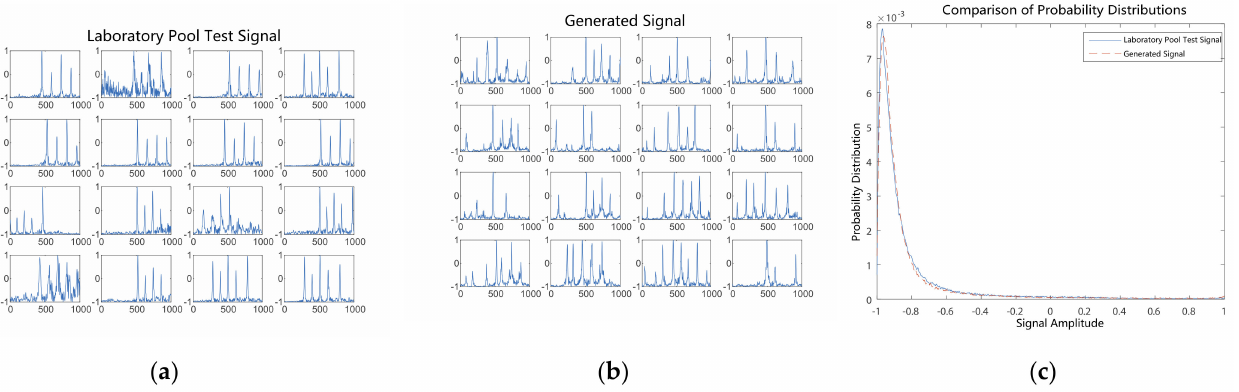
Figure 12. Comparison of generated signals with pool test signals after 150 epochs of